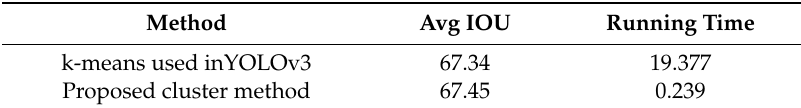
Table 2. Comparison between original YOLOv3 and proposed cluster method on the PASCAL VOC dataset: Avg IOU (%) and running time (s).